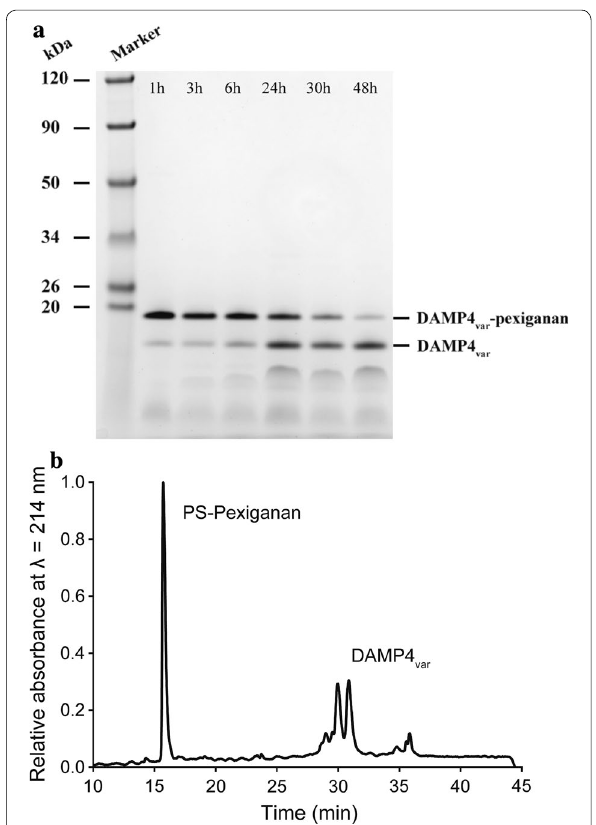
Fig. 7 a Effect of incubation time on the cleavage of DAMP4 var ‑pexiganan protein to yield the bio‑produced pexiganan peptide. b RP‑HPLC characterization of the solution composition after the cleavage and subsequent isoelectric precipitation of DAMP4 var